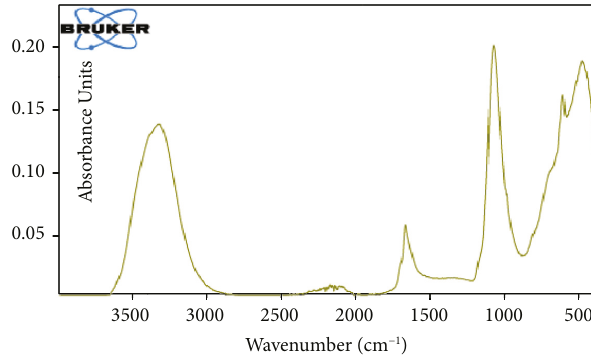
Figure 12: Nanoparticle after adsorbing